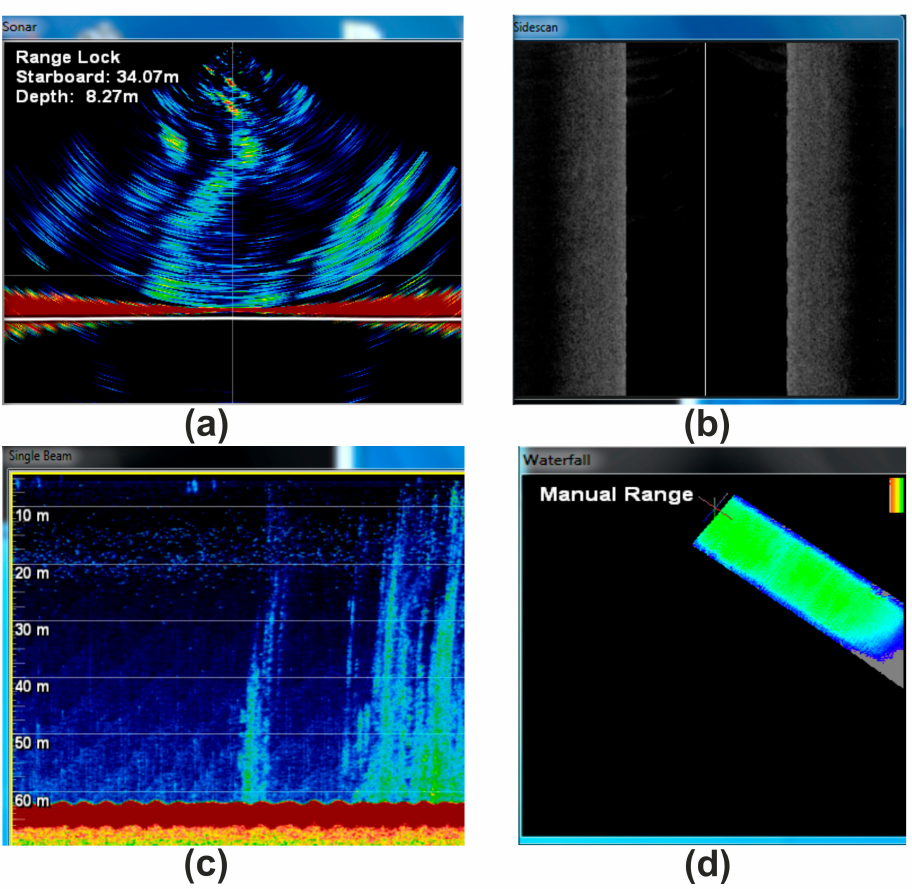
Figure 8. Screenshot of WASSP operating software demonstrating the available view types: water column sonar data ( a ), backscatter data ( b ), single beam data ( c ), and 3-D waterfall view of multibeam data ( d ). The record made at a time when a vessel passed through a gas flare in the Laptev